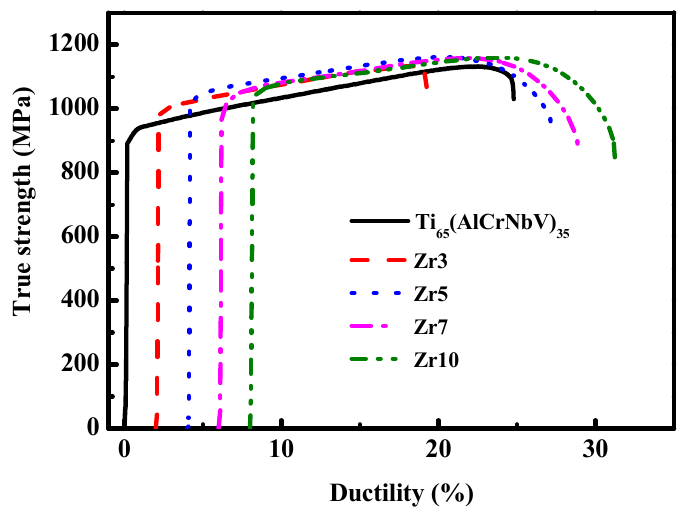
Figure 3. The tensile stress-strain curves of as-cast Ti 65 (AlCrNbV) 35 and Ti 65 (AlCrNbV) 35-x Zr x (x = 3, 5, 7, 10) MEAs. 5, 7, 10) MEAs.